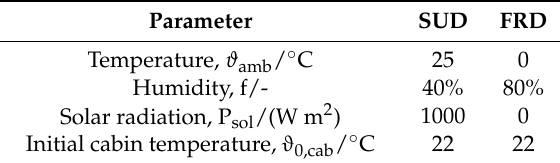
Table 7. Cases analyzed regarding interior heating and cooling. The ambient temperature of the cases SUD (summer day) and FRD (frost day) is defined in accordance with climatologic reference days from Germany’s national meteorological service, Deutscher Wetterdienst [41]. Further parameters